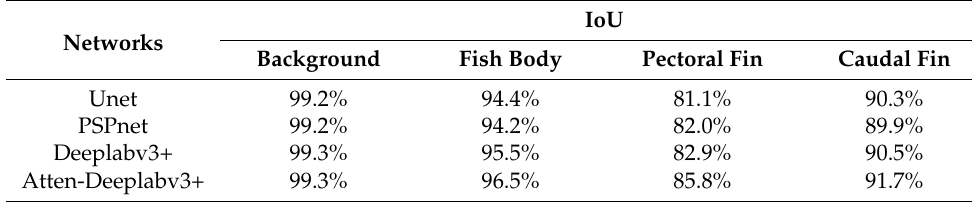
Table 1. The IoU results for semantic segmentation networks.